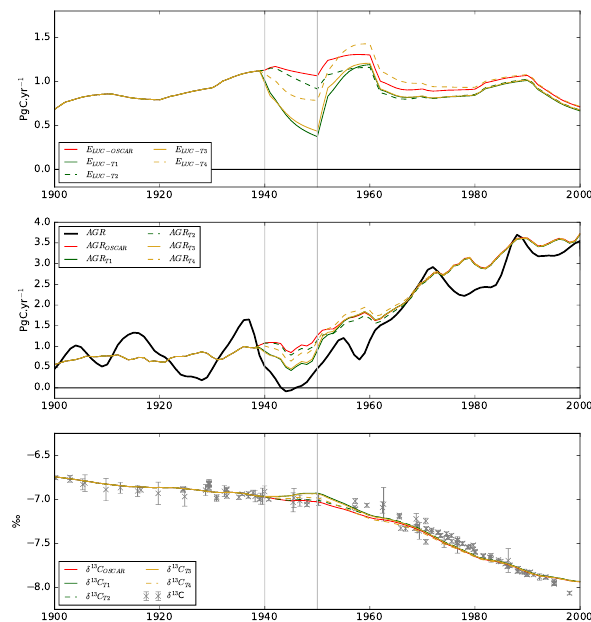
Figure 7. Resulting E LUC from OSCAR simulations for hypothet- ical scenarios about changes in LUC during 1940–1950 (top). In T1 forest conversion is set to 0 (green solid), in T2 the rate of for- est expansion during the period is doubled (green dashed), in T3 cropland and pasture expansion are stopped (yellow solid), and in T4 wood harvest is set to 0 (yellow dashed). The E LUC from each test is compared with the LUC emissions in the standard OSCAR simulation (red). The atmospheric CO 2 growth rate (AGR) result- ing from standard OSCAR and each test is compared with the ice- core record (centre). The δ 13 C values corresponding to each test (bottom) are compared with δ 13 C from the ice-core record and the corresponding uncertainty (markers and error